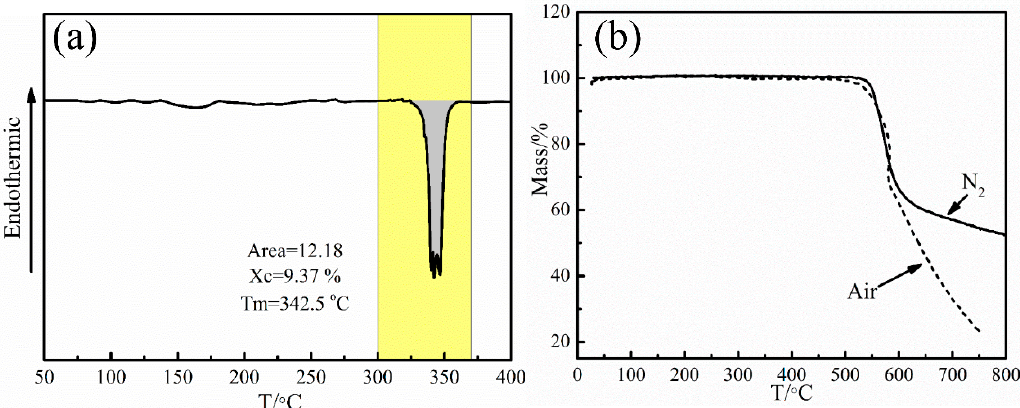
Figure 3. The DSC and TGA curves of PEEK fibers: ( a ) DSC curve of PEEK fibers in N 2 and ( b ) TGA curves of PEEK fibers in air and N 2 .